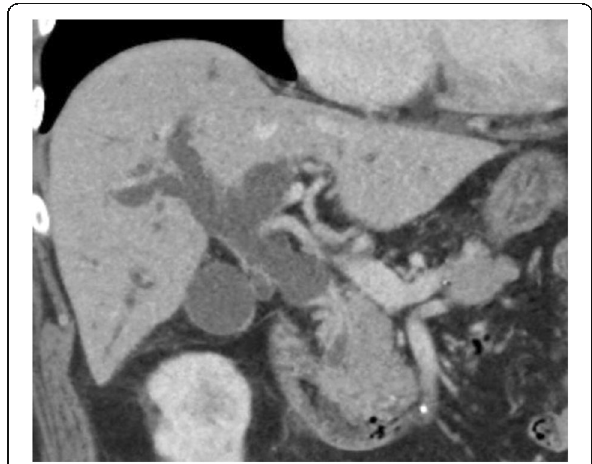
Fig. 2 Three-dimensional computed tomography showing a common bile duct